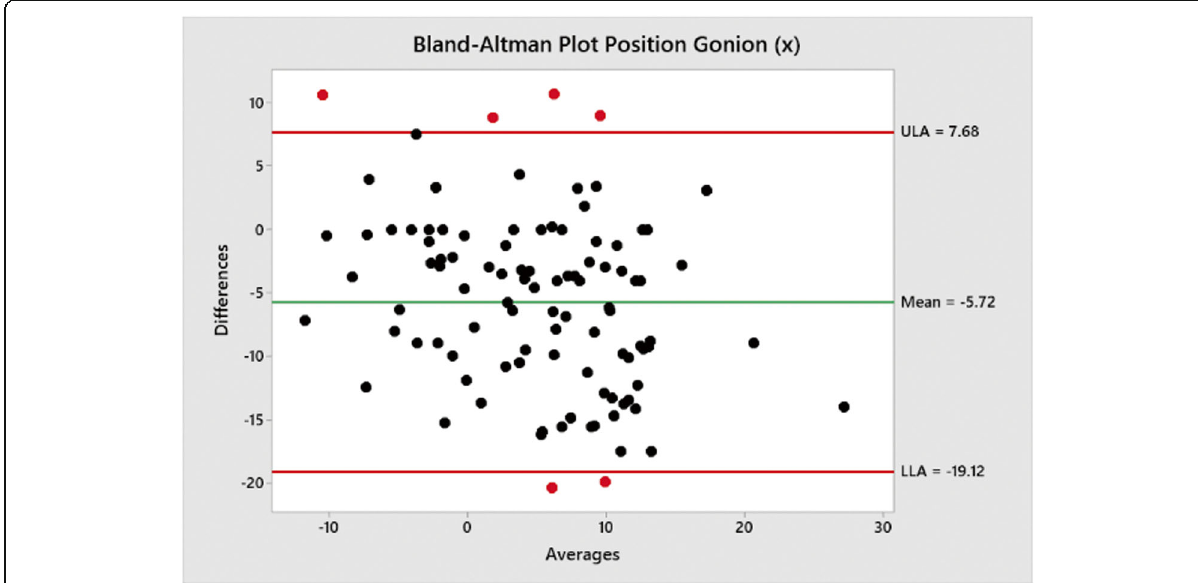
Fig. 2 Bland-Altman plot showing mean difference between traced position of Go ( x ) co-ordinate and estimated position by Sassouni+ analysis versus mean (average); the mean difference and limits of agreement are shown